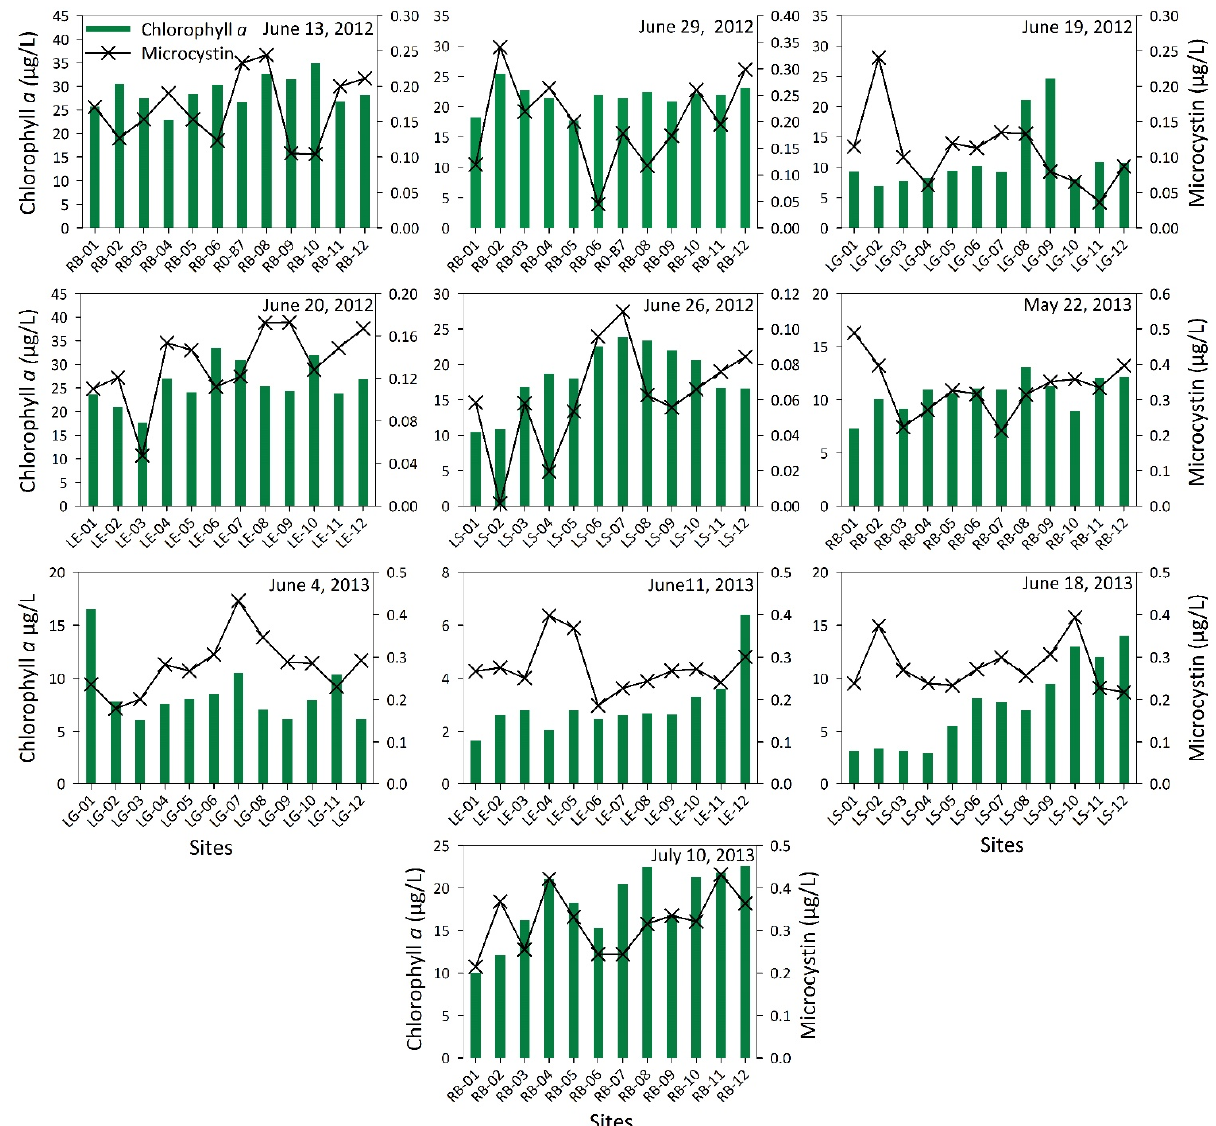
Fiure 7. Cellular microcystin concentrations shown with chlorophyll a concentrations at twelve sampling sites in each of the lakes (RB = Ross Barnett Reservoir, LG = Lake Grenada, LE = Lake Enid, and LS = Lake Sardis) with sampling dates